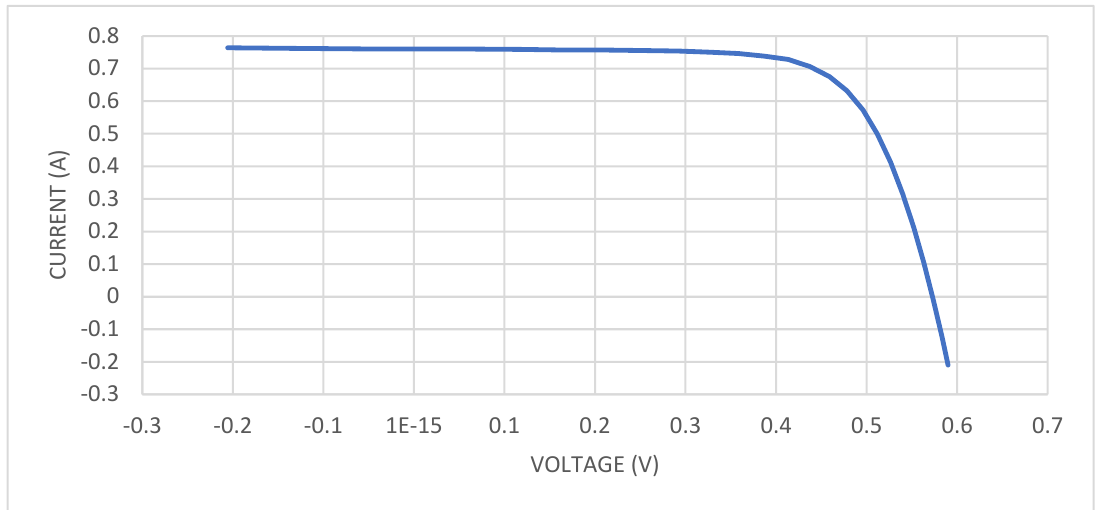
9 of 22 Table 2. Results of benchmark test functions for different optimization algorithms. MVO